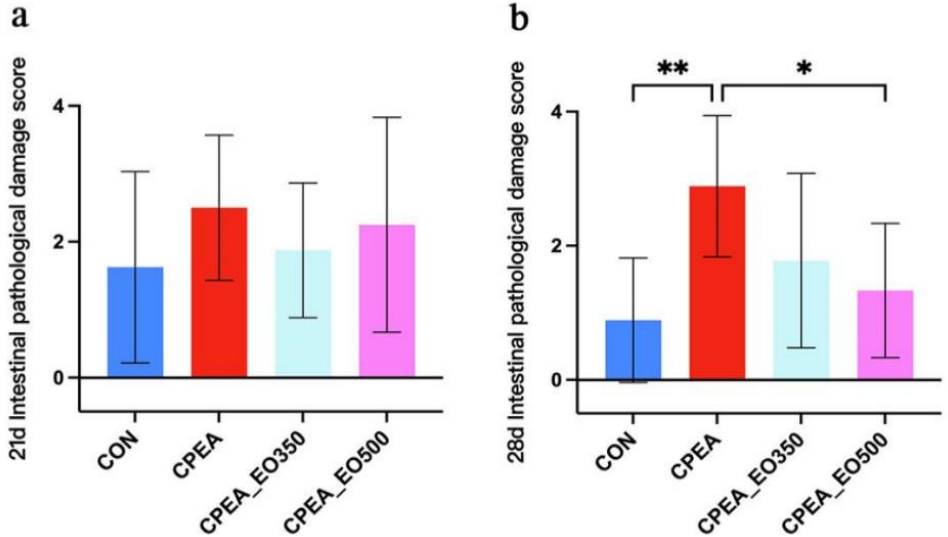
Figure 1. ( a ) 21d Intestinal pathological damage score; ( b ) 28d Intestinal pathological damage score. CON, control group birds fed a basal diet; CPEA, birds fed a basal diet and infected with Clostridium perfringens and Eimeria acervuline; CPEA-EO350, birds fed a basal diet supplemented with 350 mg/kg essential oils and infected with Clostridium perfringens and Eimeria acervuline; CPEA-